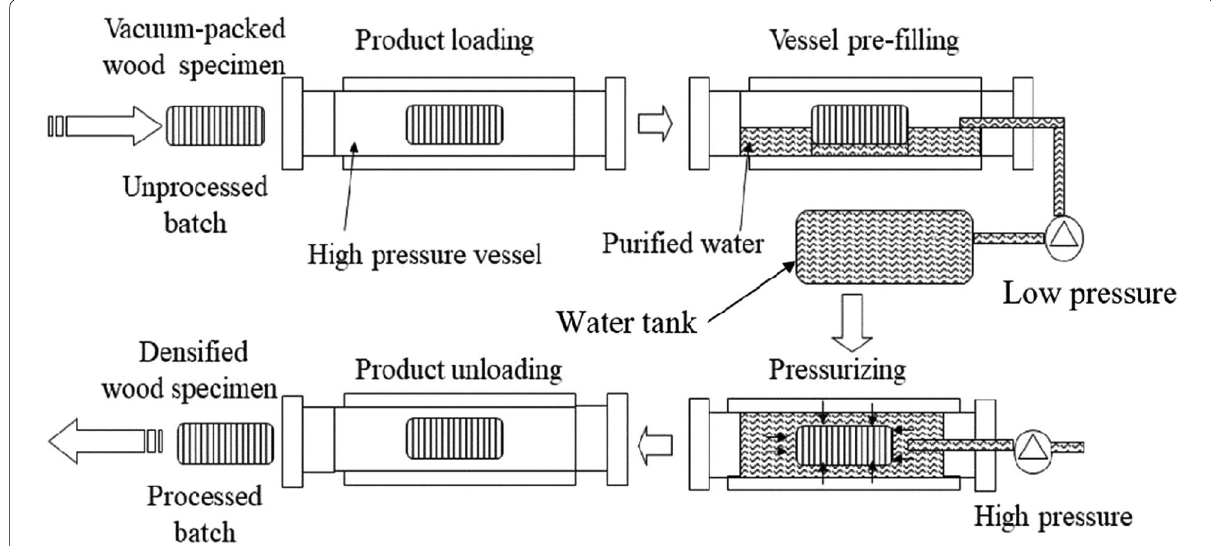
Fig. 1 Schematic illustration of the high-pressure treatment